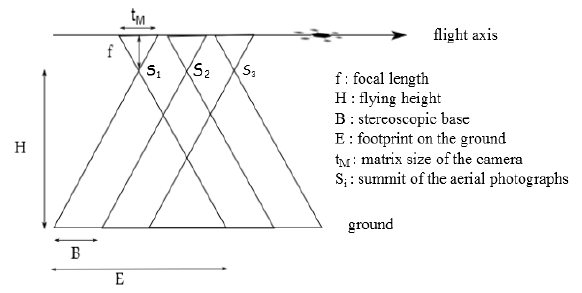
Figure 4. Representation of aerial photos parameters